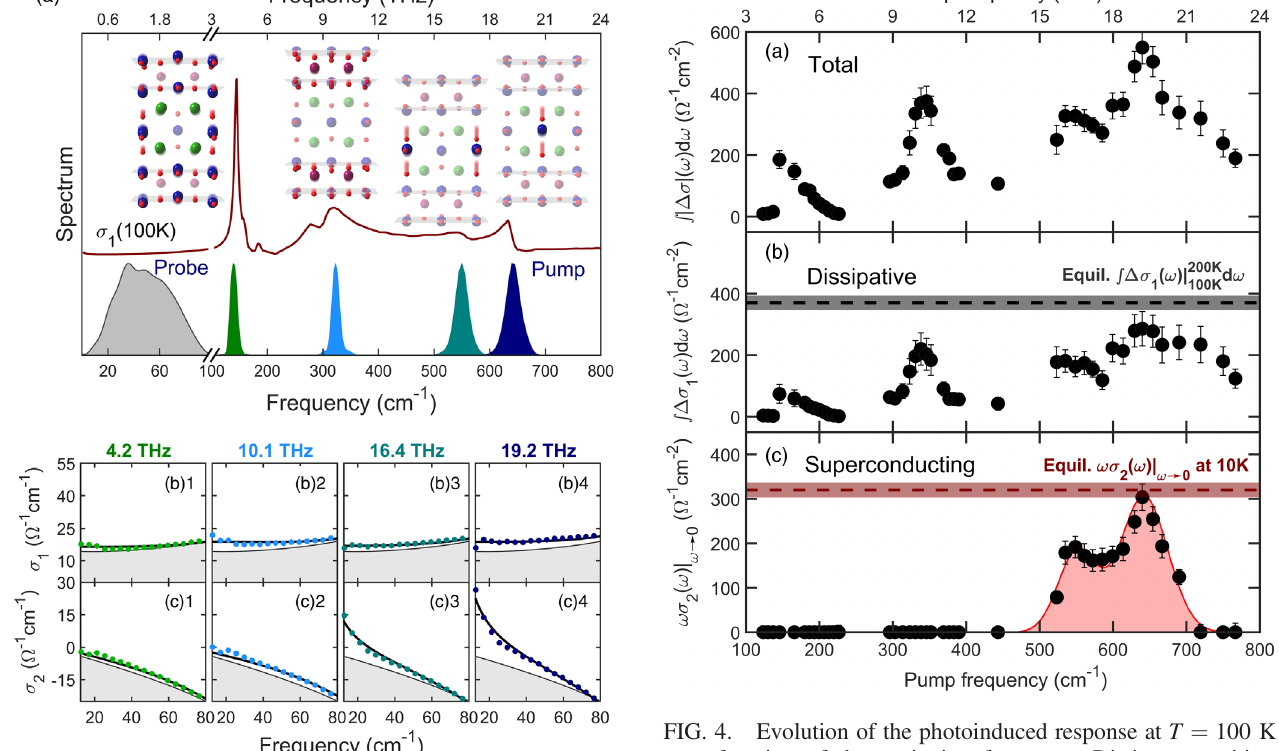
FIG. 4. Evolution of the photoinduced response at T ¼ 100 K as a function of the excitation frequency. Distinct quantities, extracted from the transient optical conductivity at τ ≃ 0 . 5 ps field).FIG. 3. Transient c -axis optical response induced by mode- time delay, are displayed as a function narrow-band excitation selective phonon excitations above T C . (a) Equilibrium c -axis frequency: (a) the total, frequency integrated change in optical R optical conductivity σ 1 ð ω Þ of YB 2 Cu 3 O 6 at 100 K ( T > T C , red . 5 j Δσ ð ω Þj d ω , (b) the frequency integrated dissipa- conductivity R solid line), along with the frequency spectra of the terahertz probe Δσ ð ω Þ d ω , and (c) the superconducting response tive response 1 (gray) and of different narrow-band pump pulses, tuned to be represented by the low-frequency limit ωσ 2 ð ω Þj ω → 0 . The red resonant with four different optical phonons at 4.2, 10.1, 16.4, shaded region represents the frequency range around the apical and 19.2 THz. The insets sketch the atomic motions related to oxygen phonon modes, where a transient superconductinglike each of these modes, with CuO 2 layers highlighted in gray and response could be identified. Horizontal dashed lines indicate the R transparency applied to quasistationary atoms (see Fig. 1 for the σ ð ω Þ d ω when heating the thermally induced increase in atom labeling). (b),(c) Complex optical conductivity σ 1 ð ω Þ þ 1 sample from 100 to 200 K (black) and the equilibrium superfluid i σ ð ω Þ measured before (gray lines) and at τ ≃ 0 . 5 ps time delay 2 density ωσ 2 ð ω Þj ω → 0 measured at T ¼ 10 K (red). All data were (colored circles) after resonant stimulation of the phonon modes taken with a pump fluence of 8 mJ = cm 2 (corresponding to shown in (a) with 8 mJ = cm 2 pump fluence (corresponding to approximately 3 MV = cm peak electric approximately 3 MV = cm peak electric field). The black solid lines are fits to the transient spectra performed with either a simple Drude-Lorentz model for normal conductors [(b)1, (b)2, (c)1, (c)2] or a model describing the response of a Josephson plasma [(b)3, (b)4, (c)3, (c)4] (see Supplemental Material [20] for more details on the fitting